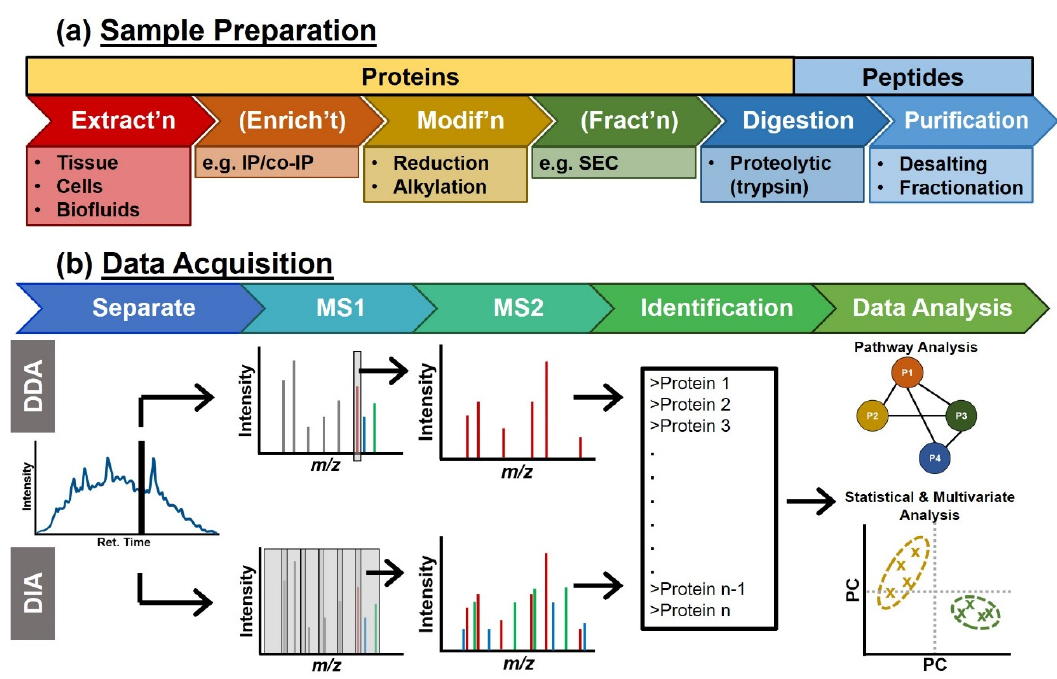
Figure 2. Standard MS-based bottom-up proteomic experiment. ( a ) First, biological samples are prepared via a bottom-up workflow, wherein the proteins are extracted from the cells and enzymatically digested into peptides. Key: IP, immuno-precipitation; SEC, size exclusion chromatography. ( b ) The resulting peptides are separated by reversed phase nanoliquid chromatography (nanoLC) and analyzed by mass spectrometry with a data-dependent acquisition method (DDA, top) or a data-independent acquisition method (DIA, bottom). A list of identified proteins is inferred from peptide sequencing using the observed MS2 fragmentation patterns. A variety of data analysis may be used. Statistical and multivariate analyses help in finding proteins that change between conditions or contribute to observed phenotypes. Over-representation and gene set enrichment analysis are used to place the obtained data in biological context. Key: Ret. Time, Retention Time; PC, principal component.